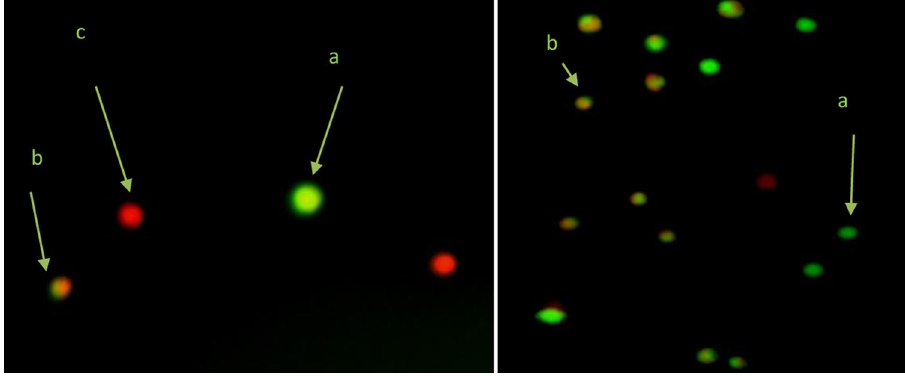
Figure 2. Typical morphological changes of haemocytes induced by ethyl acetate extract of S. commune , stained with AO/EB. The images were taken using fluorescence microscopy at 400 × . ( a ) Living cells (nuclei staining showing green chromatin with organized structures); ( b ) apoptotic cells (condensed or fragmented chromatin showing green and red color); ( c ) necrotic cells (nuclei staining similar as live cells except the chromatin is red in color instead of green).